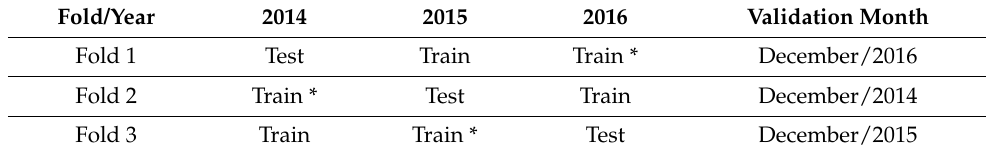
Table 4. Configuration parameters of the ANN and LSTM models of this study. ANN LSTM Parameter Value Parameter Value Activation function ReLU Activation function TanH Dropout 0.15 Dropout 0.15 Epochs 1000 Epochs 1000 Learn rate 0.001 Learn rate 0.001 Total neurons 60 Total cells Hidden layers (HLs) 2 Hidden layers (HLs) Neurons in each HL Table 5. Dataset split used in three-fold (3-fold) cross-validation for each ANN and LSTM model.